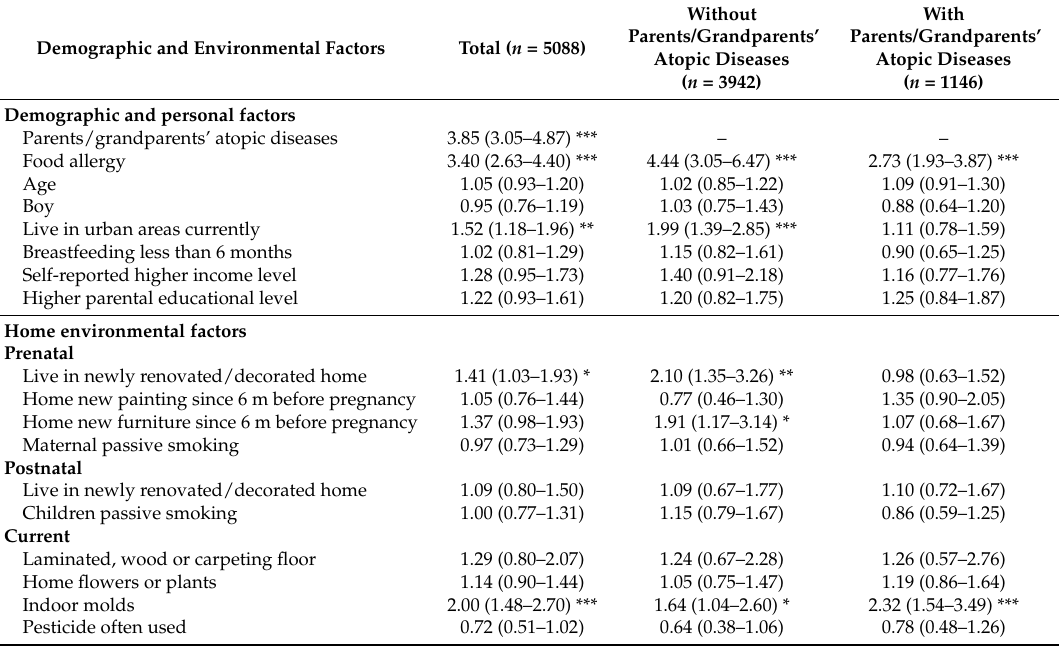
Table 2. Association (AORs and 95% CI) between childhood AD and demographic and home environmental factors in total subjects and subgroups with and without parents/grandparents’ atopic diseases † .